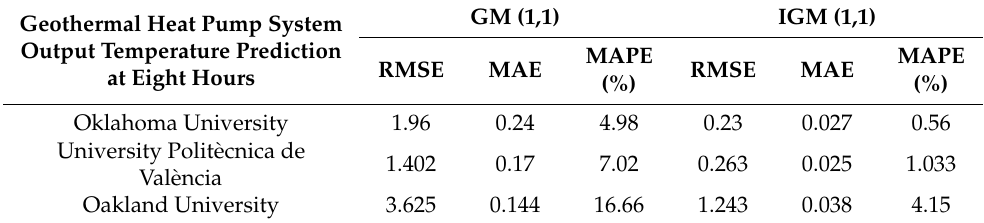
Table 4. Comparison of prediction accuracies of the IGM (1,1) and GM (1,1) models for three GHPS output temperature